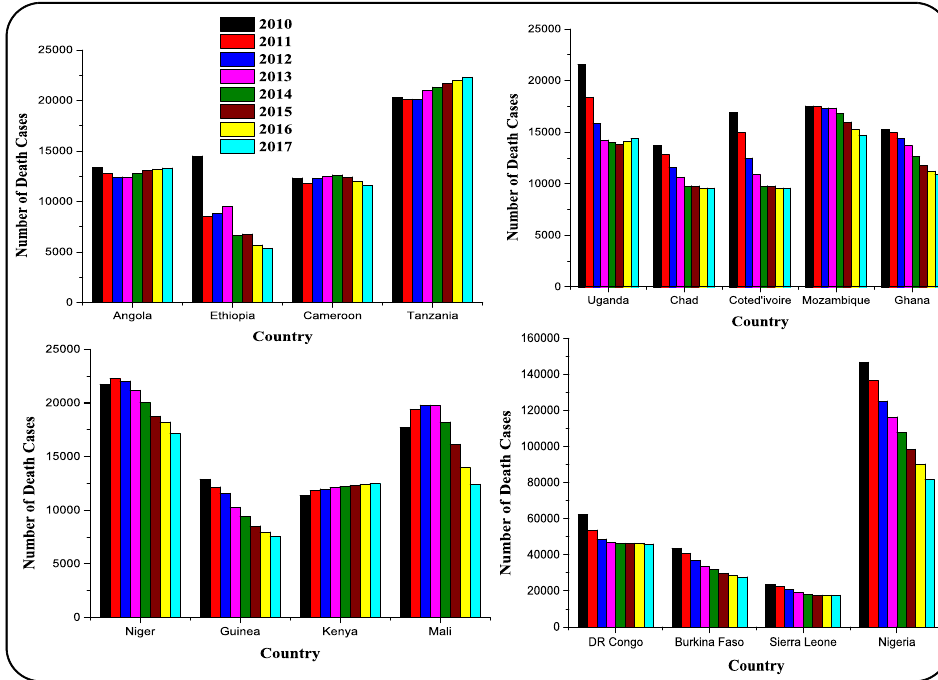
Fig. 1: Trend of Malaria Disease in sub-Saharan